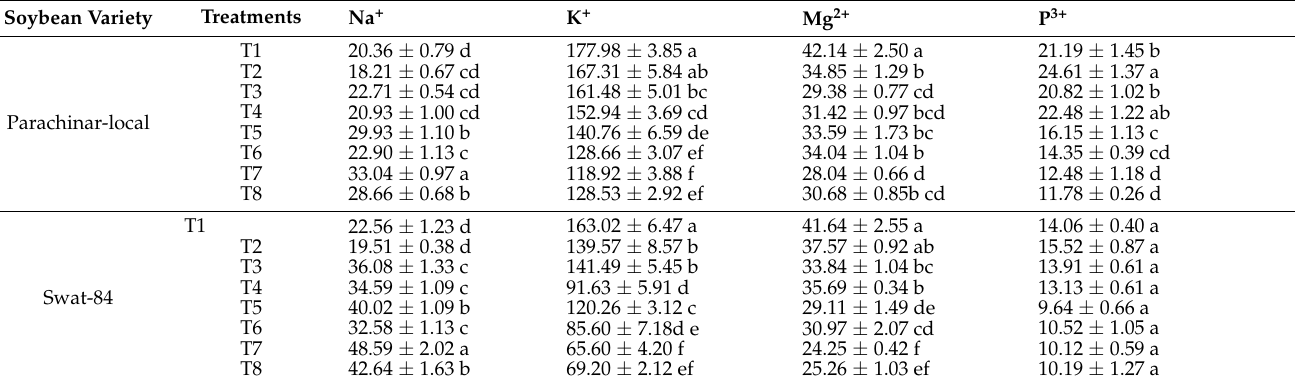
Table 4. Changes in foliar cations concentration of both soybeans.